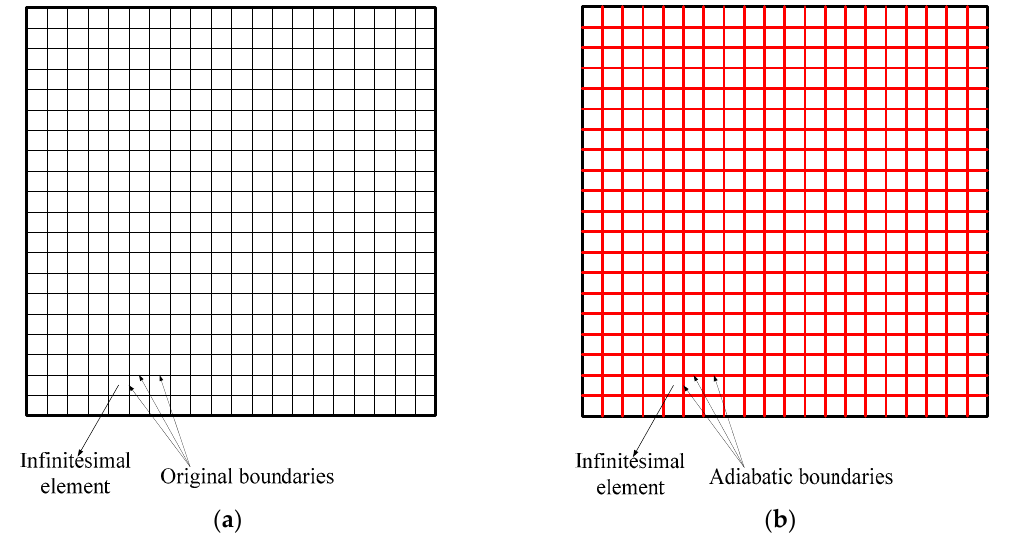
Figure 3. Boundaries of the plate ( a ) Heat transfer model with Longitudinal heat conduction (LHC); ( b ) Heat transfer model without LHC.